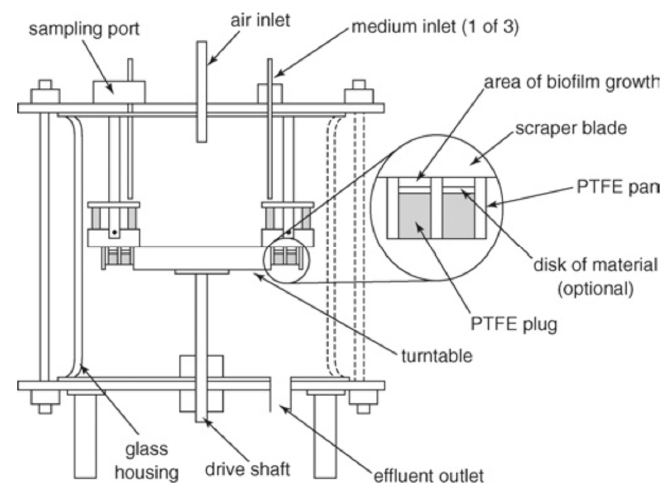
Figure 6. Configuration of the constant depth film fermenter (adapted from Pratten et al., 2007 [35], with permission from © 2007 Wiley Online Library. License number: 4131200175687).